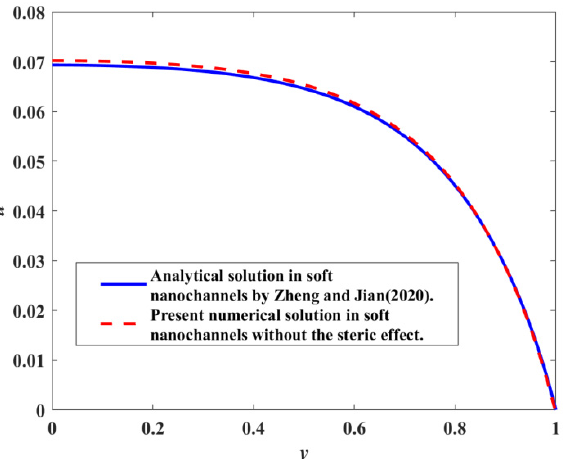
Figure 2. The comparison of the dimensionless analytical solution of velocity given by Zheng and Jian [20] with the present dimensionless numerical solution when the steric effect is ignored by setting the following parameters: ν = 0, λ = 0.2, λ FCL = 0.5, α = 1, γ = 0 and Ω = 1.